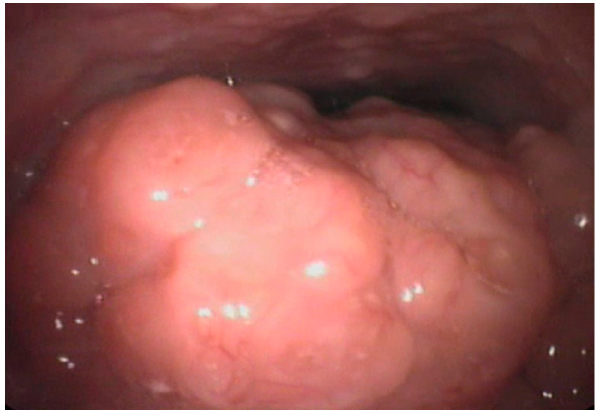
Figure 2. Lingual tonsil hypertrophy in a 11 year-old child. Courtesy of Professor C. Vicini—Department